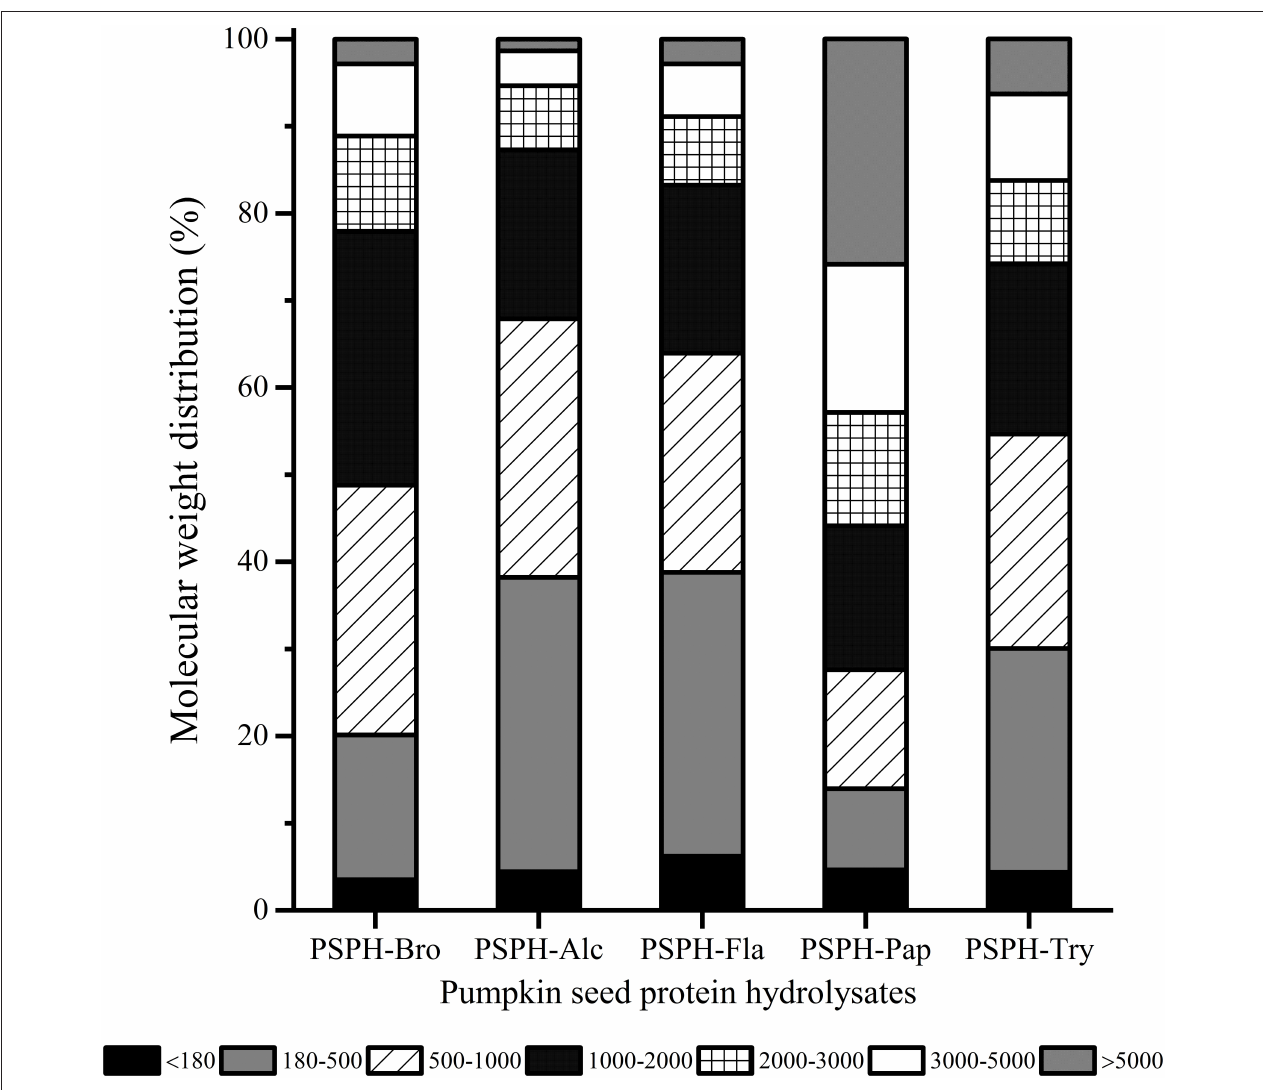
FIGURE 1 | Molecular weight distribution of pumpkin seed protein hydrolysates produced with bromelain (PSPH-Bro), alcalase (PSPH-Alc), flavourzyme (PSPH-Fla), papain (PSPH-Pap), trypsin (PSPH-Try) after hydrolysis 3h in a 2% (w/w) enzyme to substrate ratio.